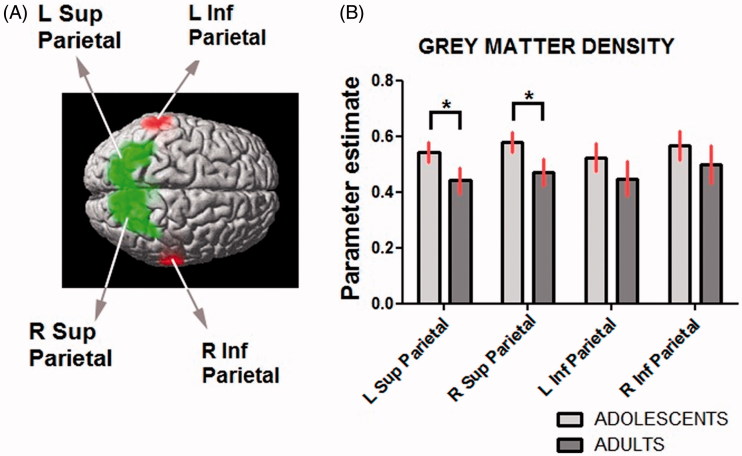
(A) The four parietal regions of interest used in this study. Two regions were placed in the superior parietal cortex (left BA7; right BA7) and two regions placed in the inferior parietal cortex (left BA40 and right BA40). (B) Parameter estimates extracted from superior parietal ROIs show significantly lower grey matter density in the adult group compared to the adolescent group (GM young > GM adults t-test (see also Table 2); * p < .05, Bonferroni corrected for multiple comparisons). Error bars depict 90% confidence intervals.